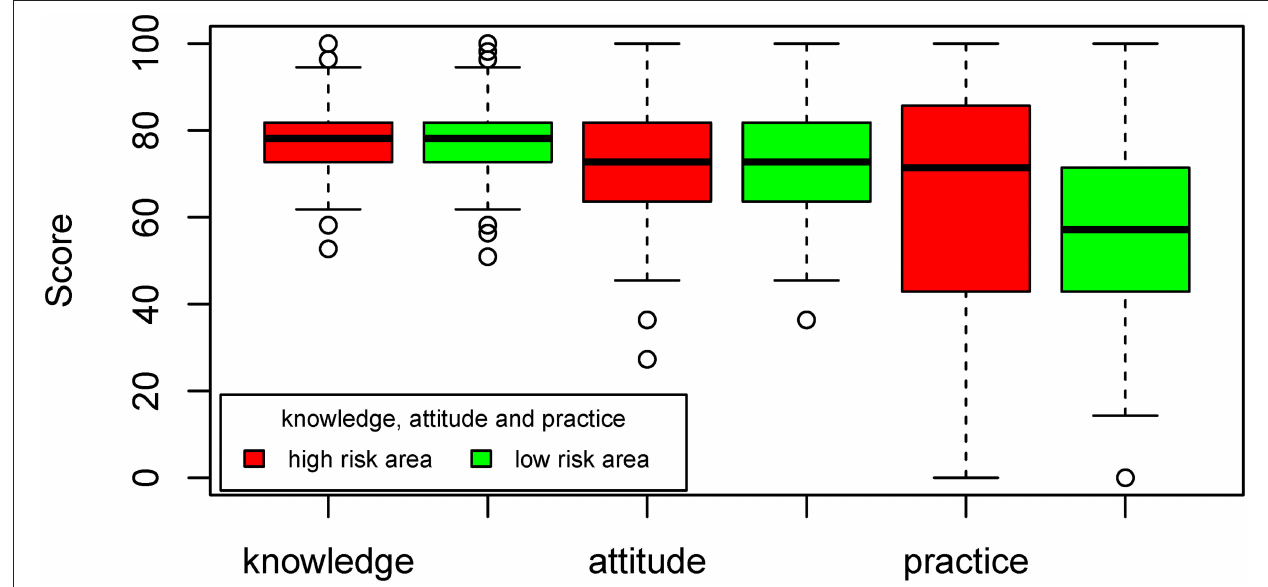
FIGURE 2 | Comparison of the adjusted scores of attitudes, knowledge, and practices between the high and low-risk areas for rabies transmission.